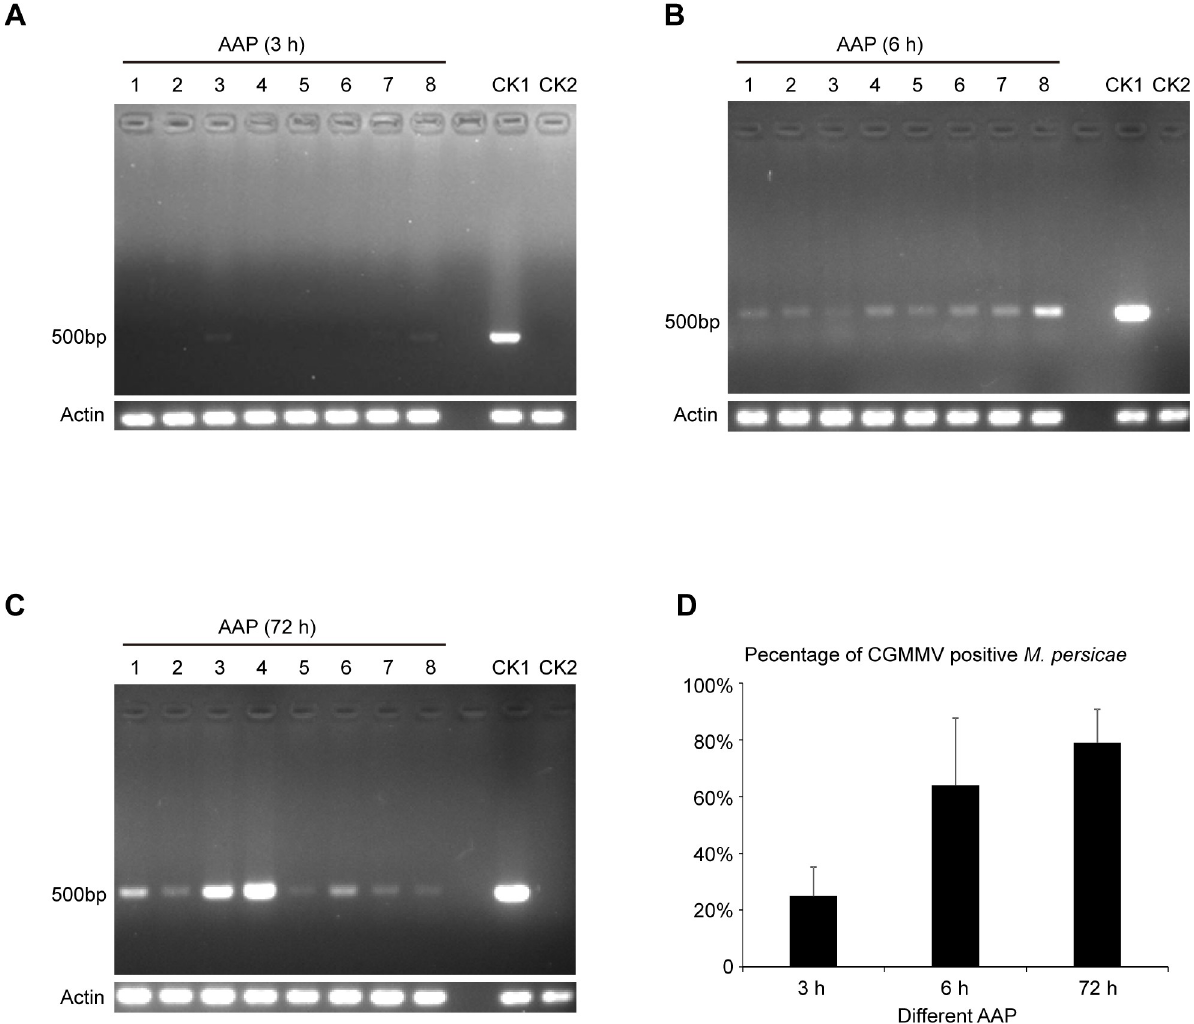
Fig 2. Acquisition of CGMMV from CGMMV-infected N . benthamiana plants by M . persicae . RT-PCR analysis on CGMMV in M . persicae fed on the CGMMV-infected N . benthamiana plants for 3 h (A), 6 h (B) and 72 h (C). Three biological replicates were set for each treatment. The CGMMV